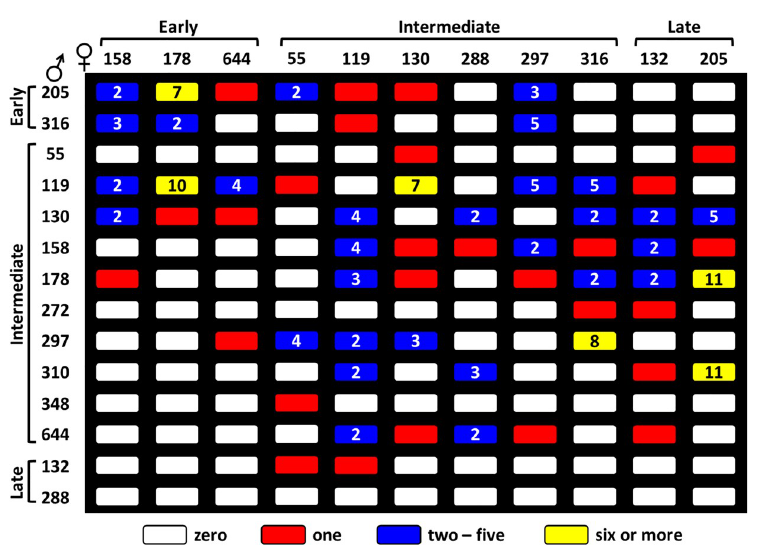
Fig 6. Cross pollination based on timing of female and male flowering in Lo